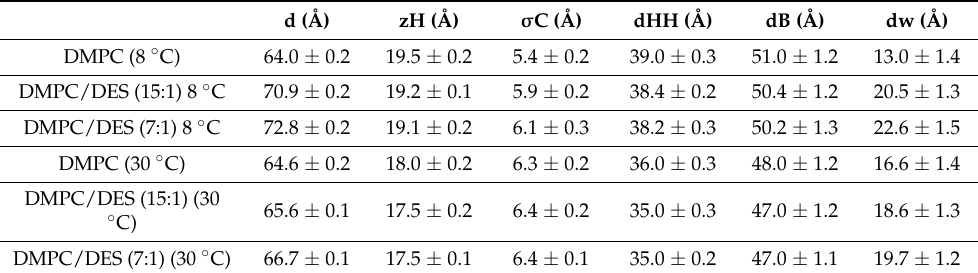
Figure 5. 31 P-NMR spectra of pure DEPE ( A )) and DEPE containing 80:1 ( B ) and 40:1 ( C ) DEPE/DES molar ratios at different temperatures. The spectra were normalized to the same signal height. Table 2. Parameters extracted from the SADX diffractograms by using the GAP (global analysis program): zH, position of the headgroup Gaussian of the electron density profile; σ C, standard variation (width) of the Gaussian describing the hydrocarbon tails; dHH, headgroup peak − peak distance; dB, total bilayer thickness (polar head plus hydrophobic layer); dw, water